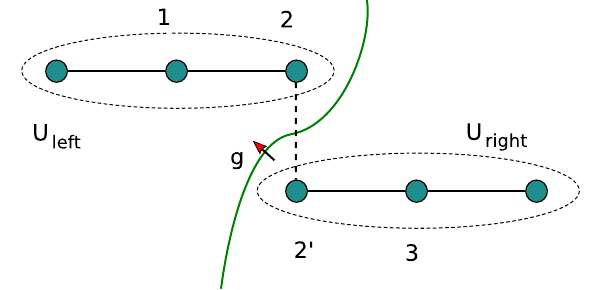
FIG. 12. In this approach to defining the Hamiltonian coupled to a crystalline gauge field, patches are allowed to overlap to include some vertices. In this particular example, U includes vertex 2, which gets duplicated. Hamiltonian terms (denoted by solid edges) lying entirely inside U taken to act on those Hilbert spaces. Then, spurious degrees of freedom are eliminated by applying a projection operator, which, in a product state basis, identifies the state at 2 with g applied to the state at 2 ’ . This is indicated by the green curve labeled by g cutting the dashed vertical line from 2 to 2 ’